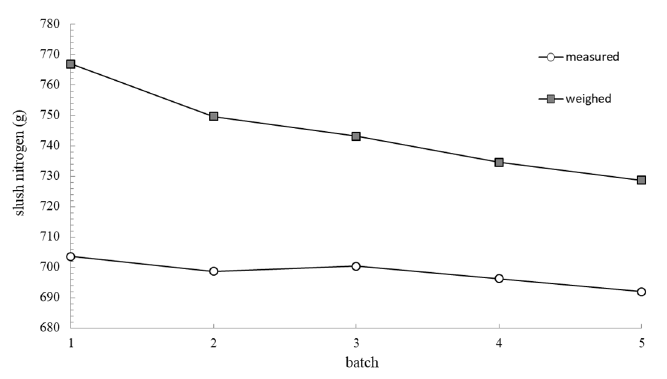
Figure 8. Measured and weighed values of the transferred slush. Table 3. Mass flow measured and weighed at different densities of the slush mixture. Batch No.